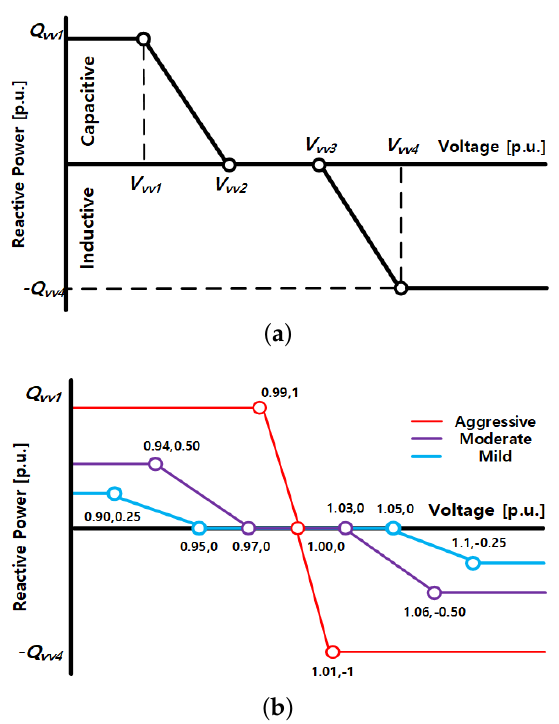
Figure 3. Volt–Var Function Curve. ( a ) Common Volt–Var Function Curve [23,24,28]. ( b ) Standard Default Setting of Volt–Var Function